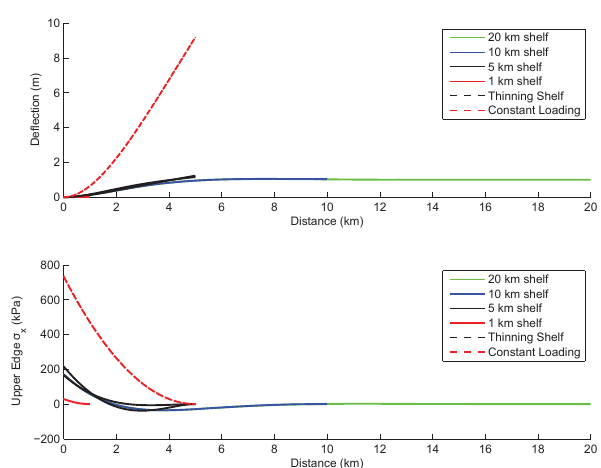
Figure B1. Results of the 1-D flexural beam approximation of a floating ice shelf. The upper figure shows the beam deflection, while the lower section shows the stress at the upper edge of the beam. See text in Appendix B for a description of the governing equations and boundary conditions for the models shown.